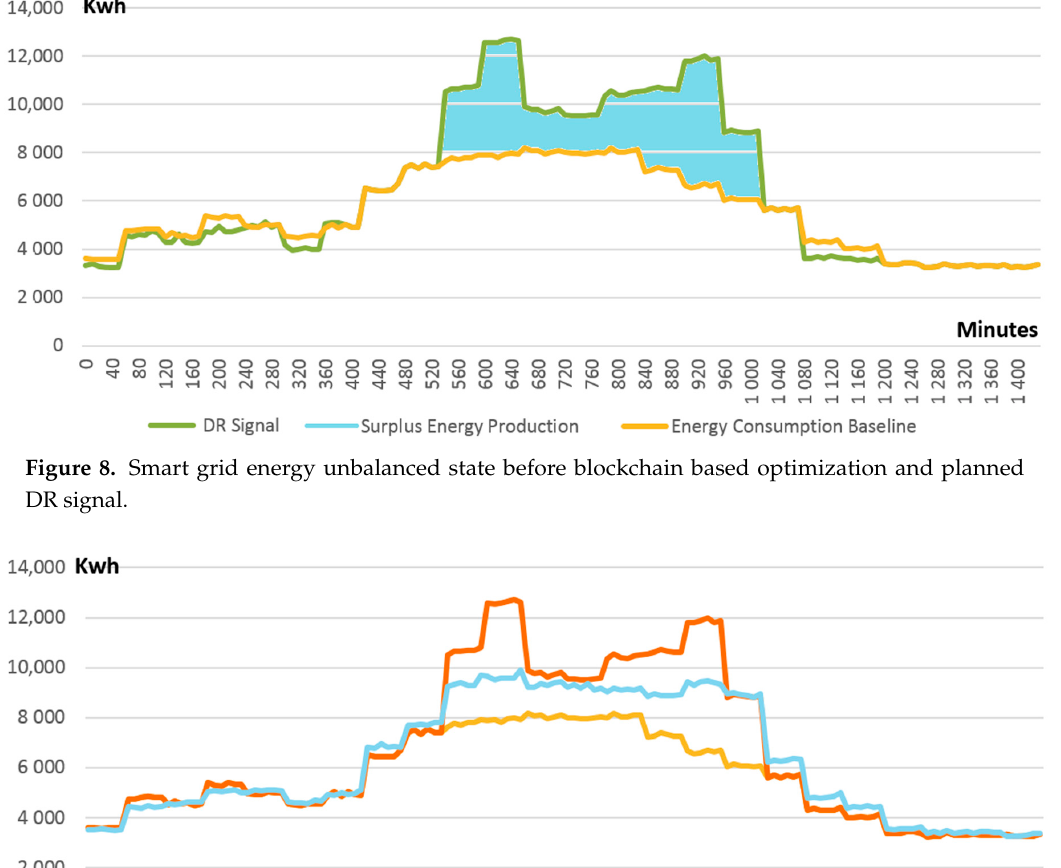
Figure 7. Code excerpt from the smart contract managing DEP energy profile.